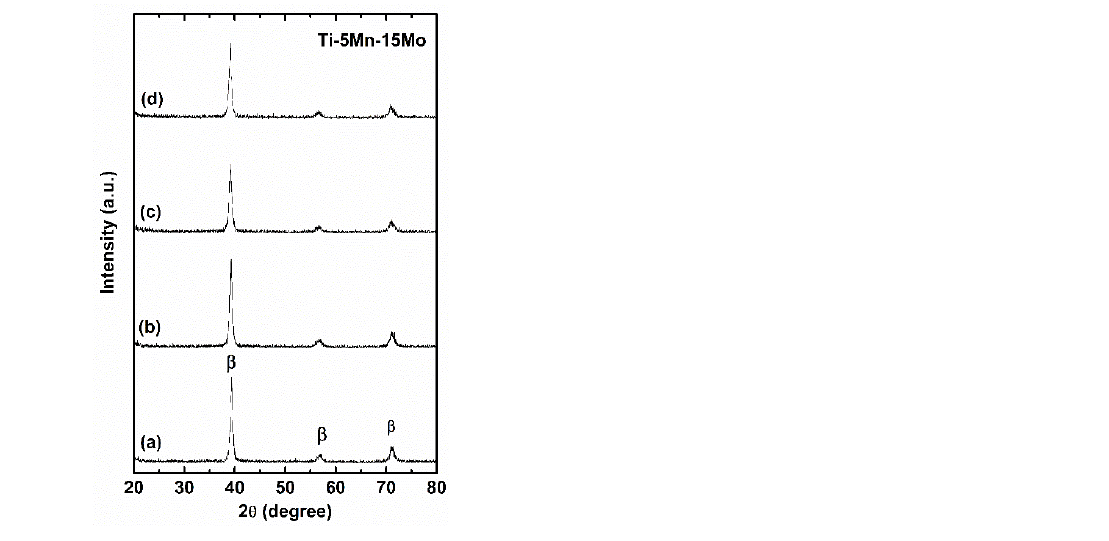
Figure 2. X-ray diffractograms for Ti-5Mn-15Mo alloy after homogenization heat treatment ( a ), after the hot-rolling process ( b ), and after the solution ( c ) and annealing ( d ) heat treatments. Figures 3 and 4 show the optical micrographs (200×) and the micrographs obtained by SEM (2000×) for Ti-5Mn-10Mo and Ti-5Mn-15Mo alloys, respectively, in all processing